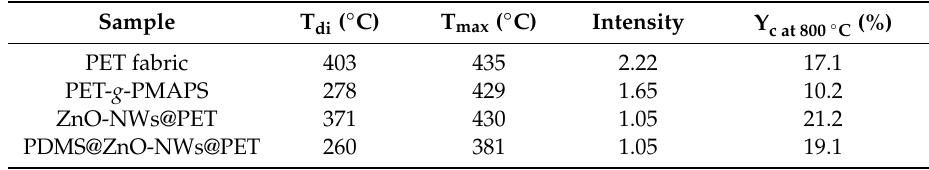
Table 1. Typical parameters obtained from TG analysis of pristine PET fabric, PET- g